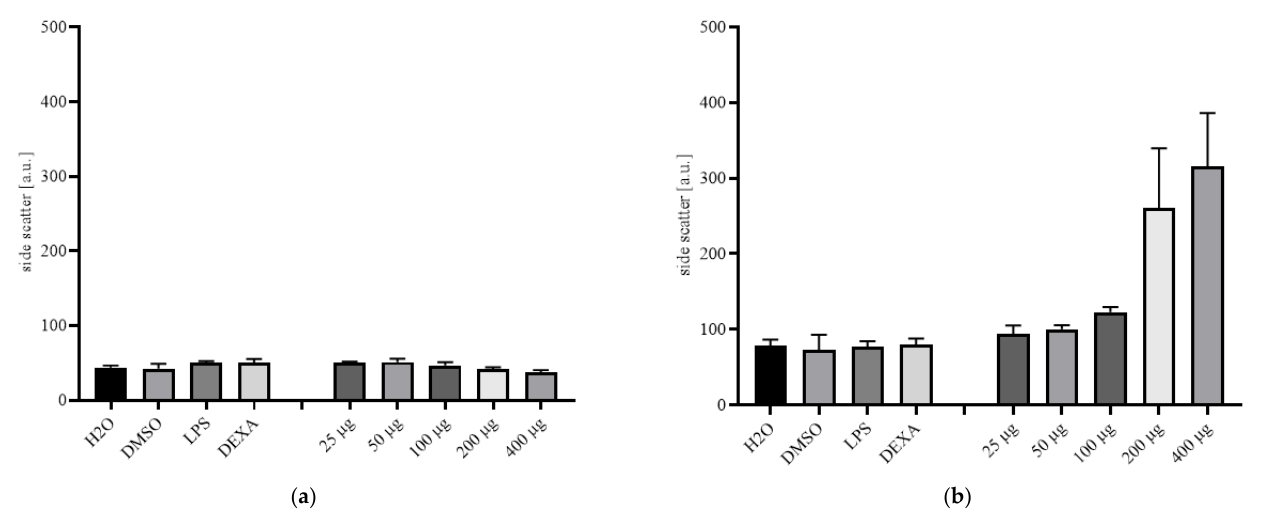
17 of 19 Figure A6. Effects of SPION HAp on viability of EL4 cells (ATCC ® TIB-39™). Cells were incubated with SPION HAp particle concentrations of 25 to 400 µg/ml and additional